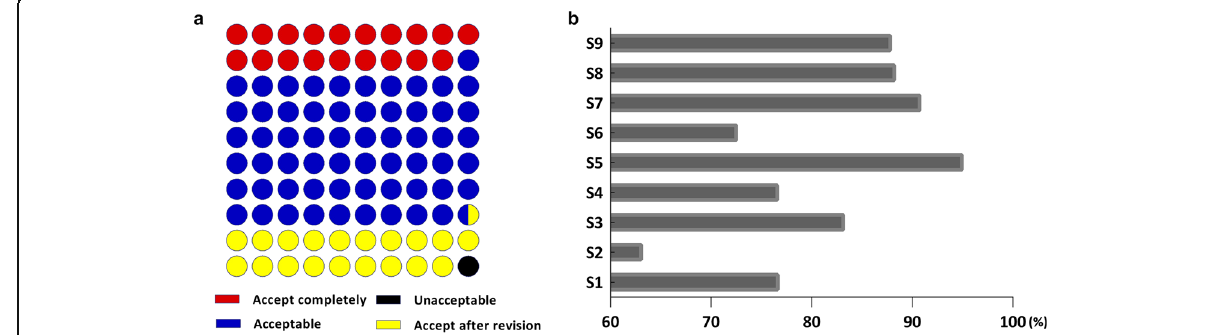
Fig. 4 Views on comprehensive assessment of clinical practice guidelines for traditional Chinese medicine. a Comprehensive assessment requires CM clinicians to make a judgment of CPGs. Perceived views on comprehensive assessment of CPGs for CM are given as percentage response rates of accept completely ( red ), acceptable ( blue ), accept after revision ( yellow ) and unacceptable ( blue ). Four-fifths (80.07%) selected ‘ acceptable ’ (60.84%) and ‘ accept after revision ’ (19.23%), ‘ accept completely ’ (18.81%) and ‘ unacceptable ’ (1.12%). b Comprehensive assessment of CPGs for CM by nine specialties. S1: Internal medicine; S2: Oncology; S3: Surgery; S4: Gynaecology; S5: Paediatrics; S6: Ophthalmology; S7: